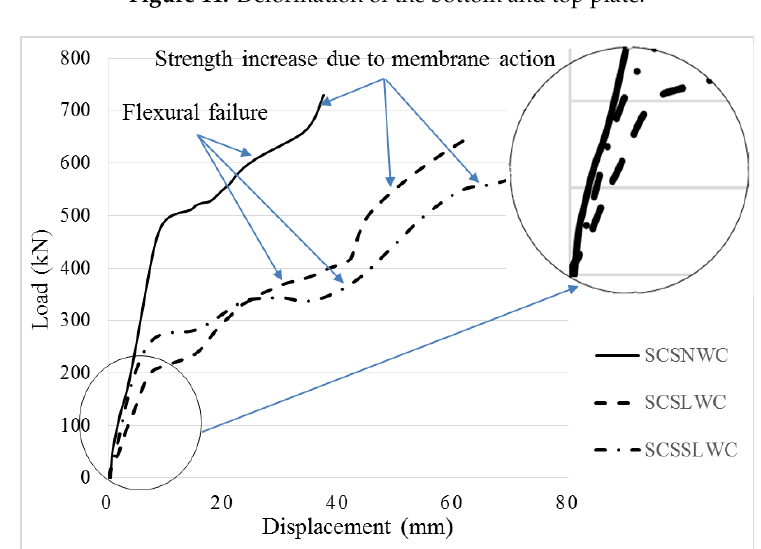
Figure 12. Load-displacement curves of specimens.